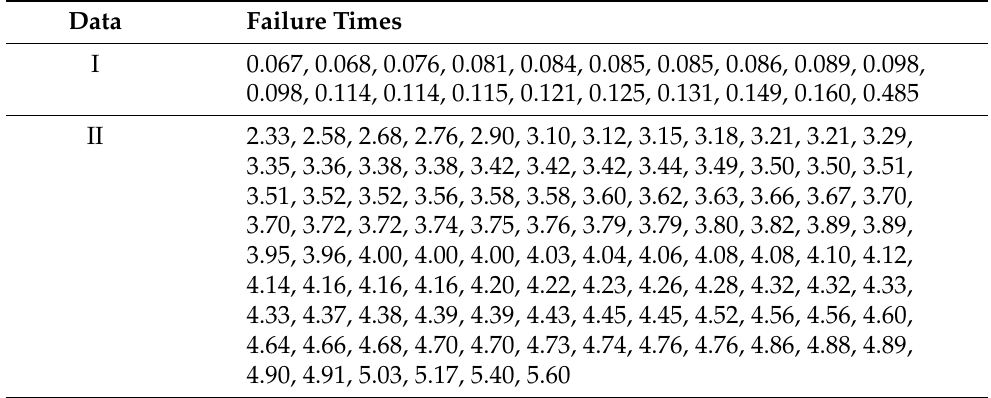
Table 2. The failure times of mechanical components and metal-coupons.